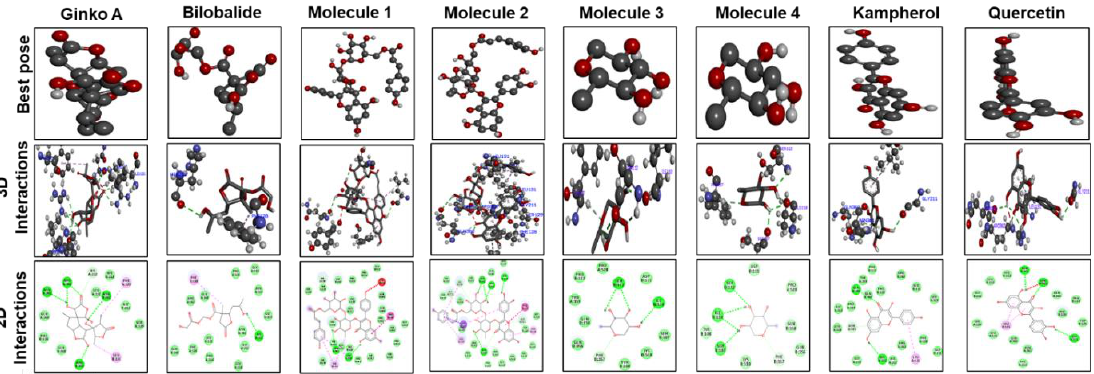
Figure 9. The different panels represent the docking analysis and best pose of ginkgolide A, bilobalide, 3-O-(2′-O-(6′-O-(p-coumaroyl)-β- D -glucosyl)-α- L -rhamnosyl) kaempferol (Molecule 1), 3-O-(2′-O-(6′-O-(p-coumaroyl)-β- D -glucosyl)-α- L -rhamnosyl) quercetin (Molecule 2), 3-O-(2′-O,6′-O-bis(α-L-rhamnosyl)-β- D -glucosyl) kaempferol (Molecule 3), 3-O-(2′-O,6′-O-bis(α- L -rhamnosyl)-β- D -glucosyl) quercetin (Molecule 4), quercetin, and kaempferol, after docking with COX2. Both 2D and 3D shapes of the drug-receptor complex were visualized by DSV.